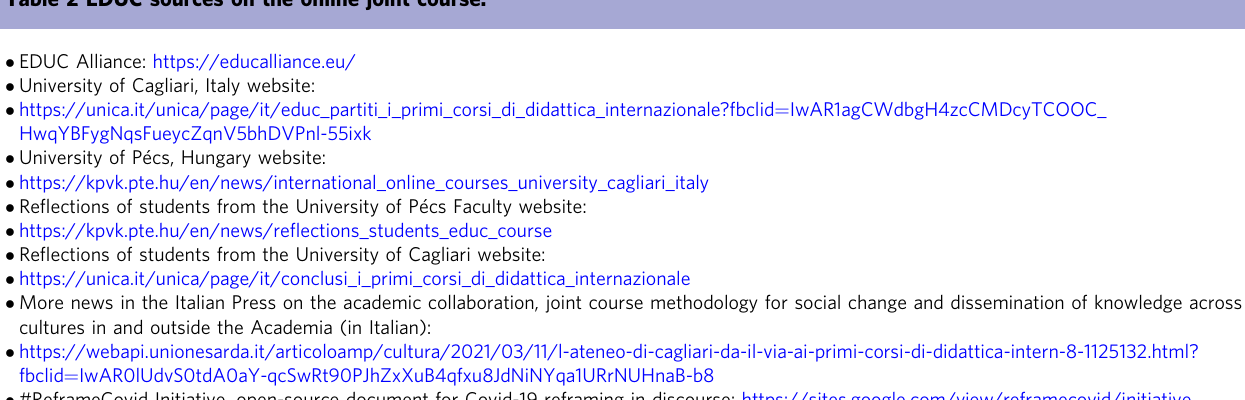
Table 2 EDUC sources on the online joint